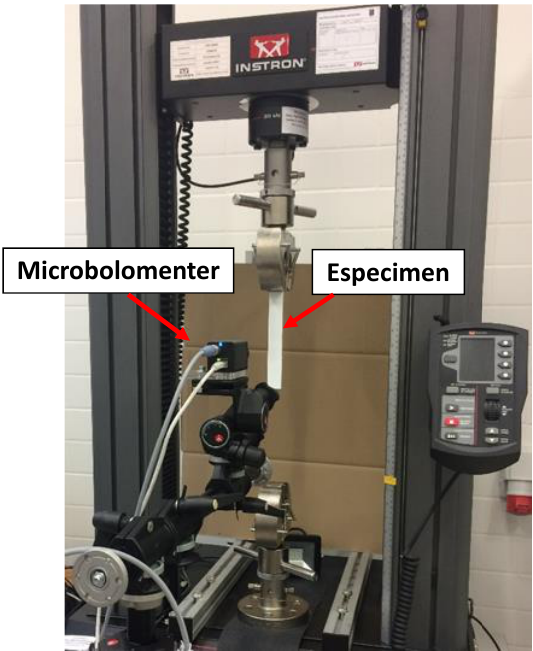
Figure 2 . Set-up for solid rigid test for 2DDIC . Figure 2. Set-up for solid rigid test for